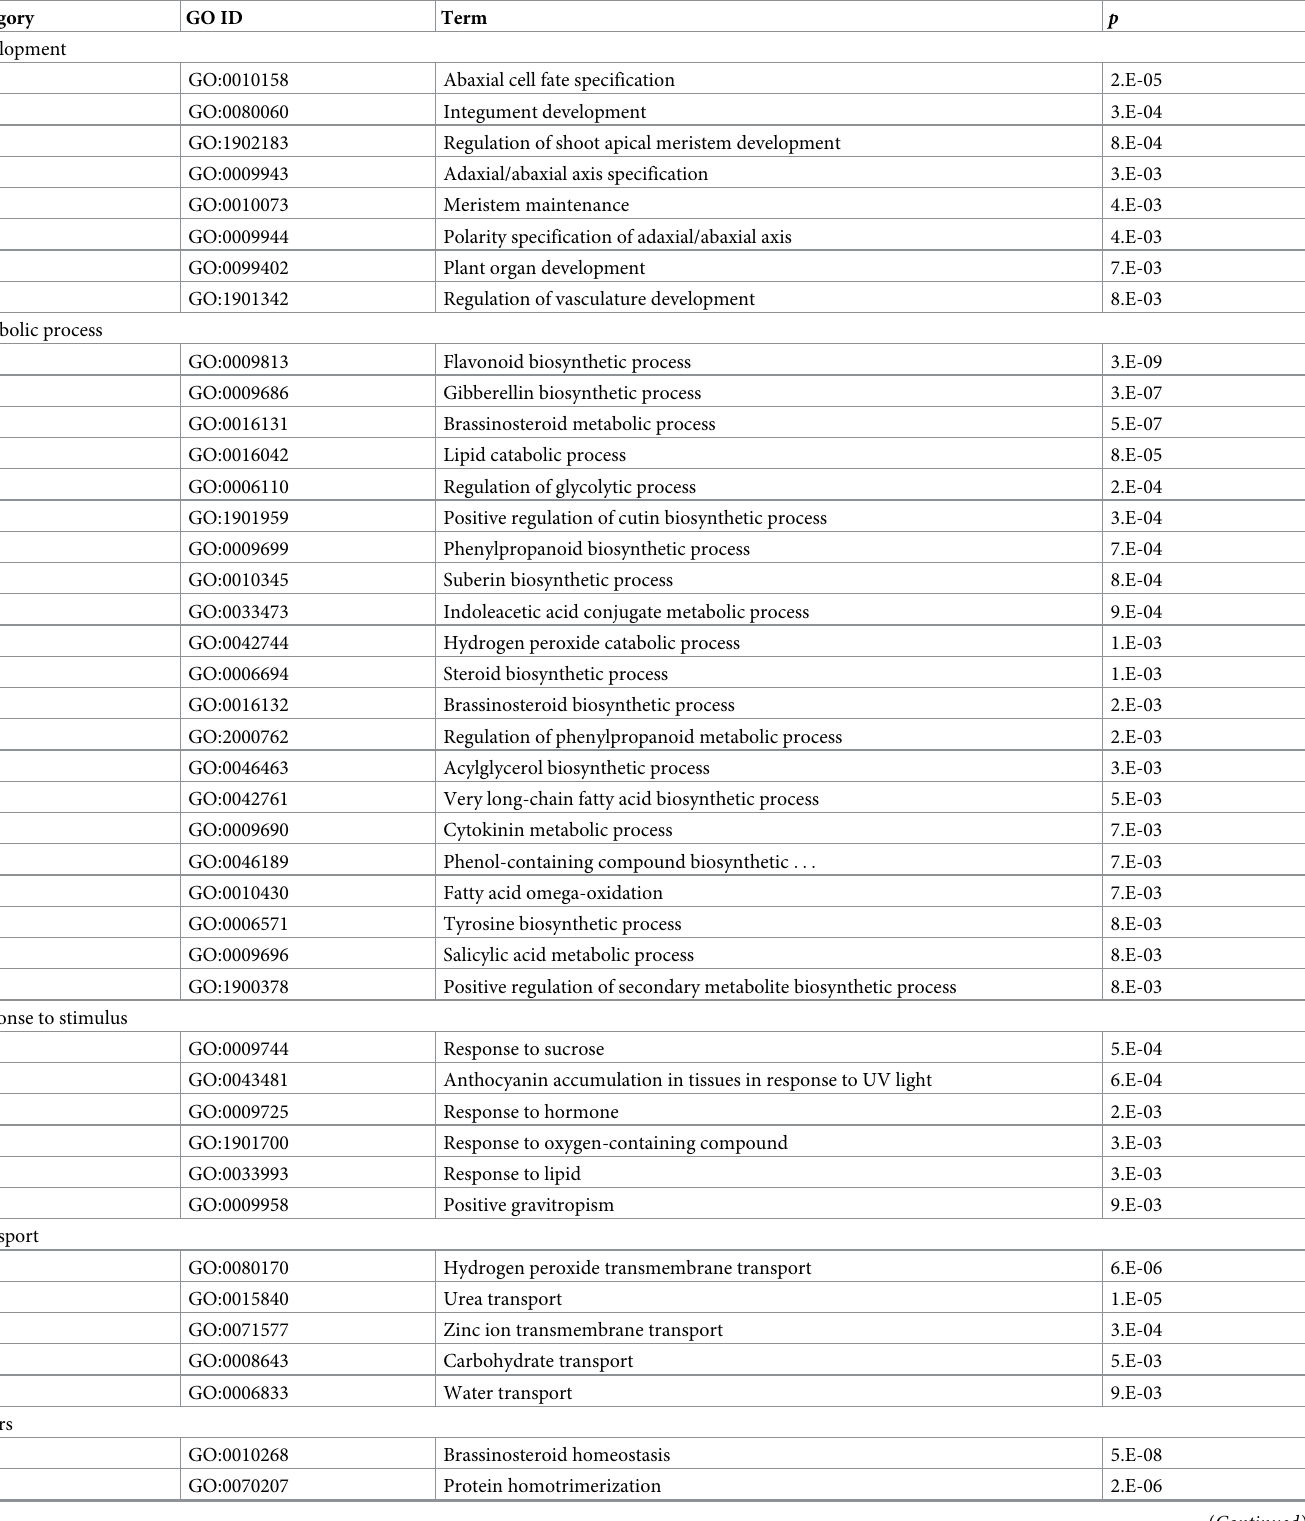
Table 1. Over-represented Gene Ontology (GO) terms in the 742 genes upregulated in high embryogenic Cryptomeria japonica embryonal masses.